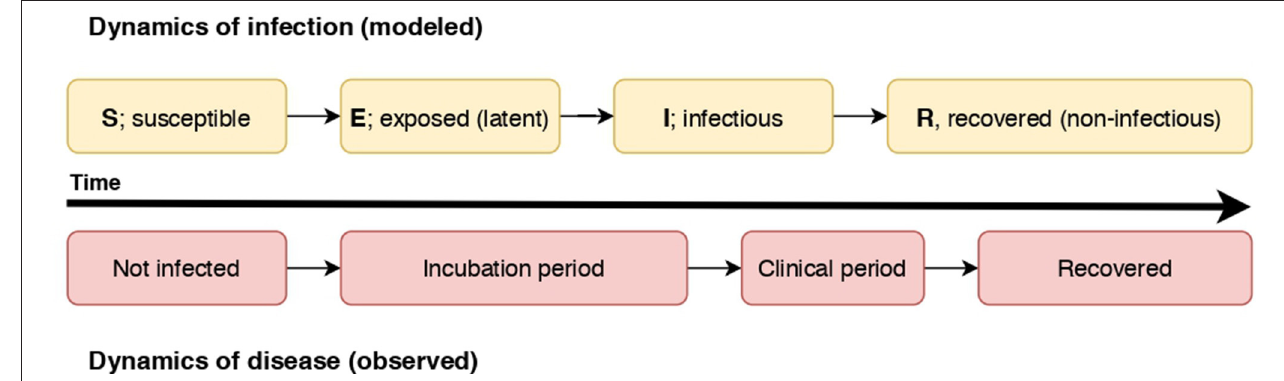
FIGURE 1 | A diagram illustrating the relationship of the dynamics of an SEIR infectious process and observed disease states in individuals. In this case, individuals become non-infectious prior to resolution of clinical signs.